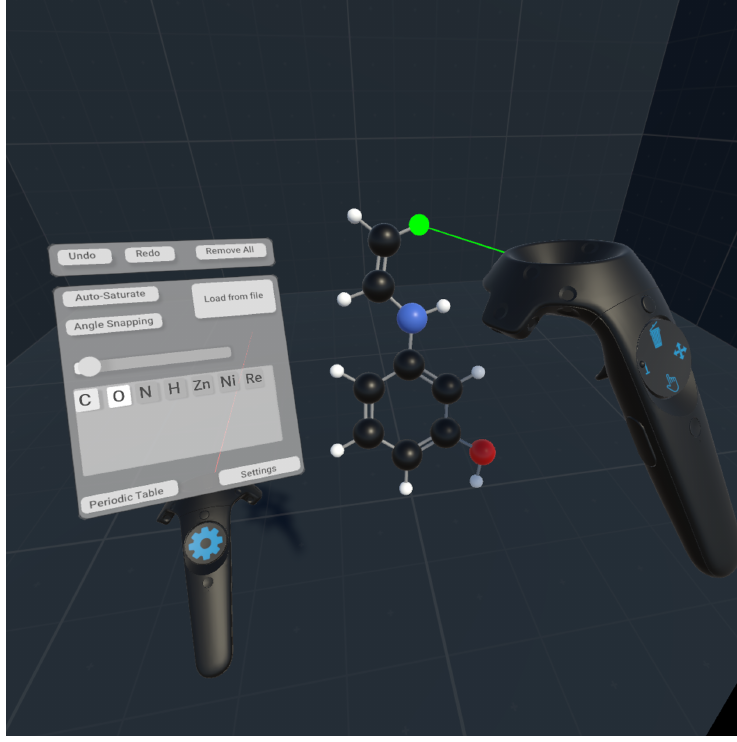
Figure 4. Building a molecule in VRChem using wireless hand controllers.